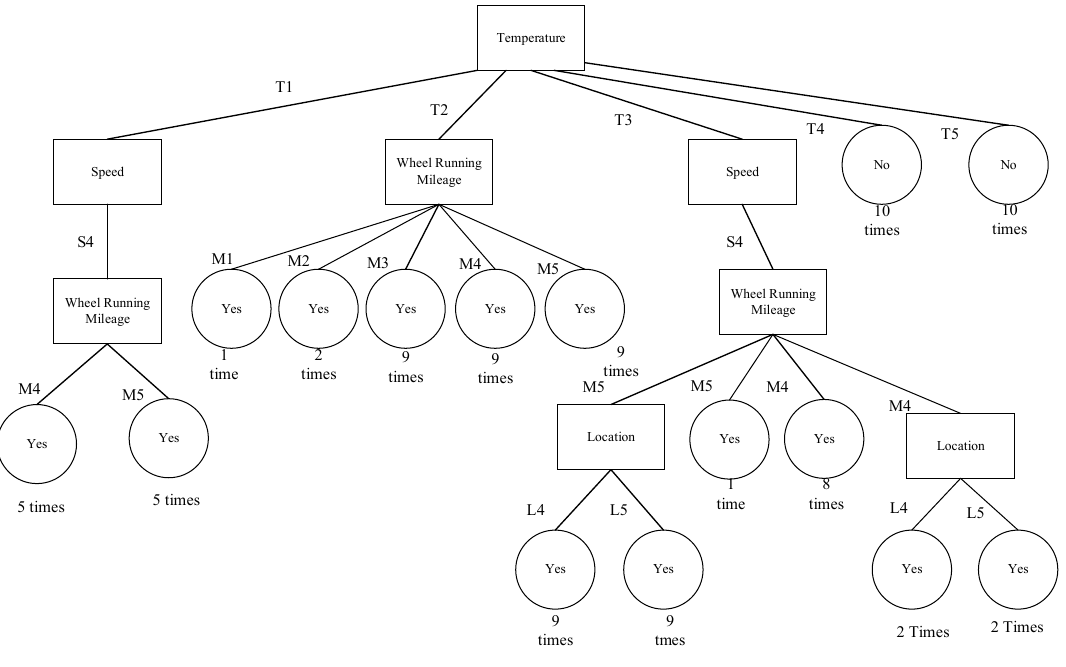
Figure 7. Ten analysis results of decision tree.